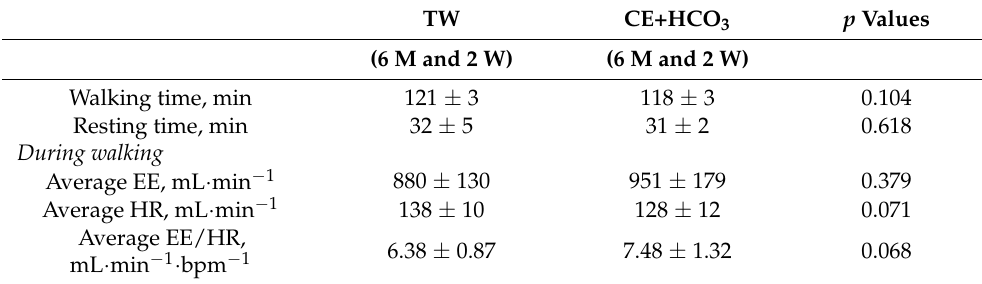
Table 2. Summarized results of time and physiological variables during mountain trekking. TW CE+HCO